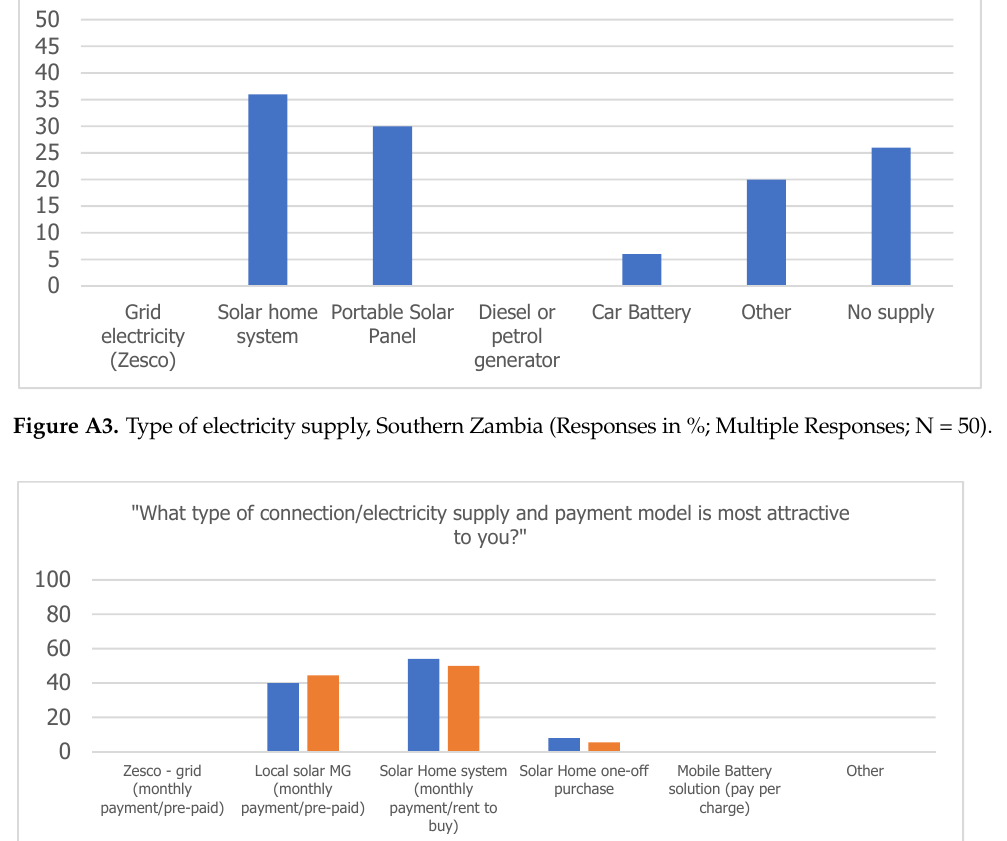
Figure A2. Reasons for low income; Southern Zambia; N = 50; Responses in %; Multiple responses possible.